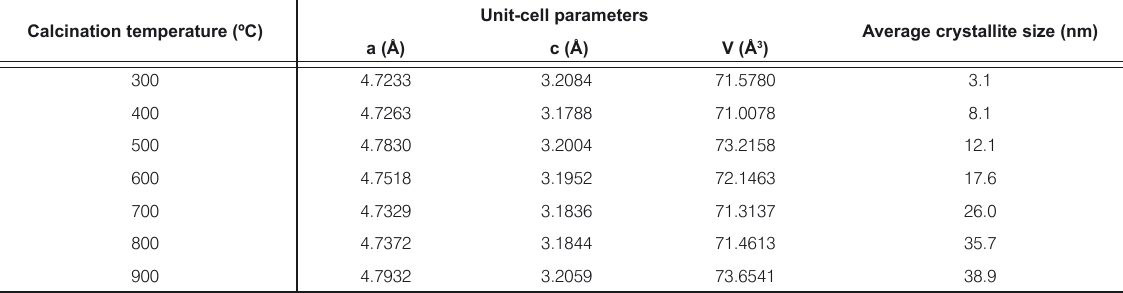
Table 2. Unit-cell parameters and average crystallite size of nano-sized SnO different temperatures.